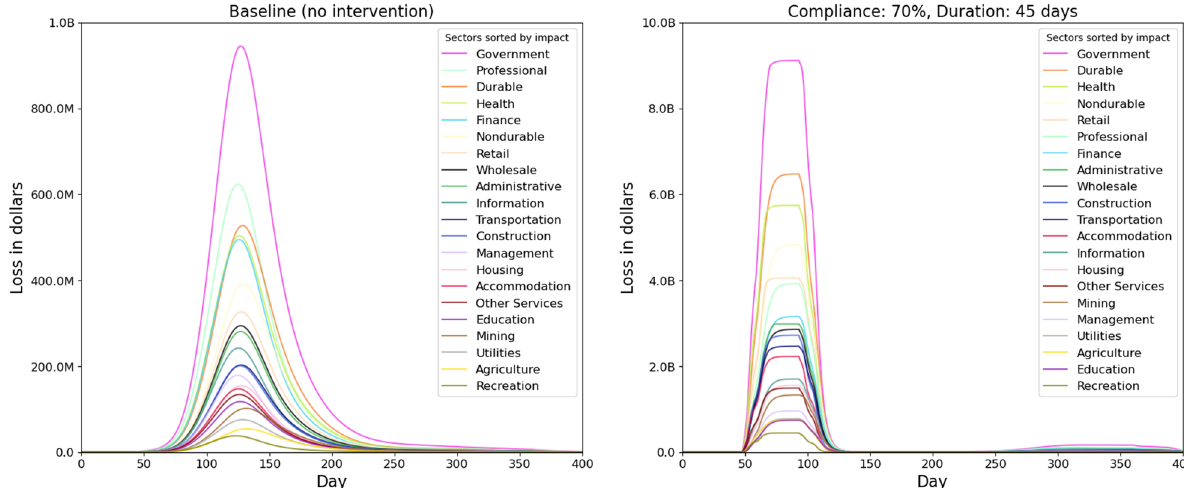
Figure 10. Sector level daily losses caused by the inoperability of each sector and its cascading impact on other sectors due to interdependencies between sectors. The left subfigure shows losses for the unmitigated case. The right subfigure shows losses for the mitigated scenario VHI_70_SH_70_45. The ordering of sectors in the legend is ranked by the height of the curve. Note that the scale of loss (y-axis) in the right subfigure is ten times of the left